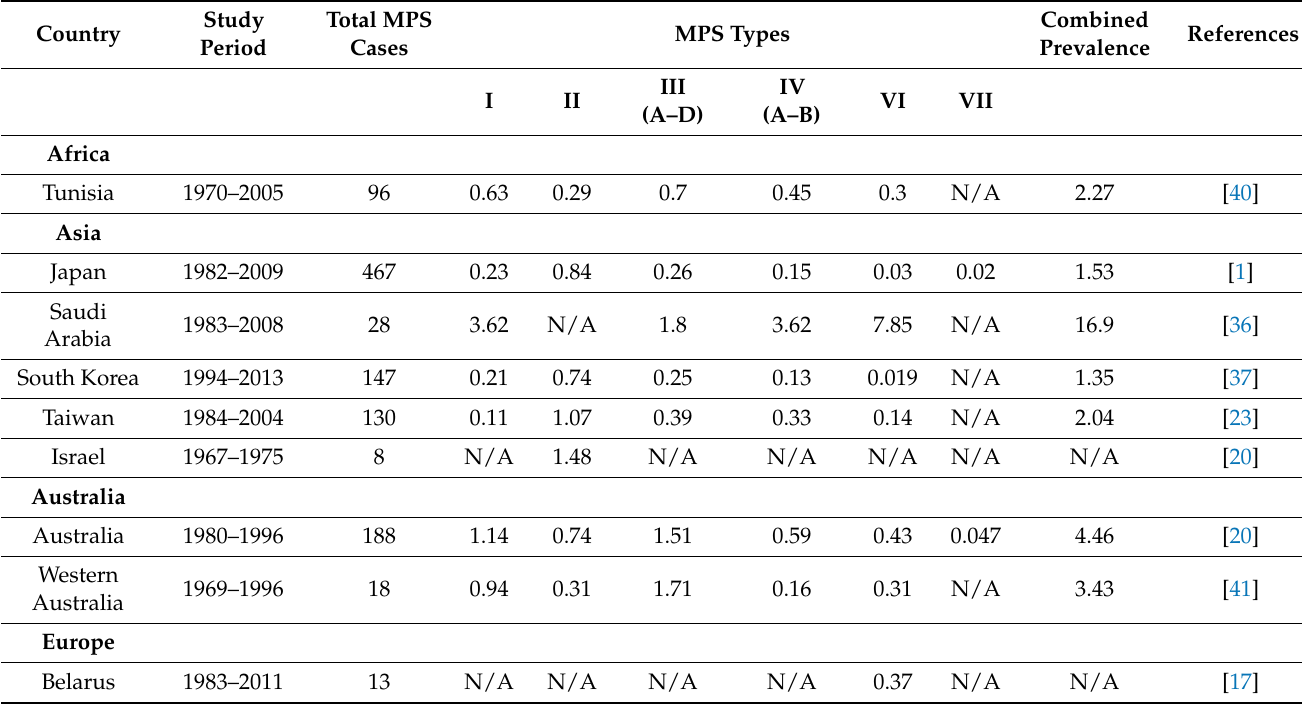
Table 2. MPS cases and prevalence in different countries by